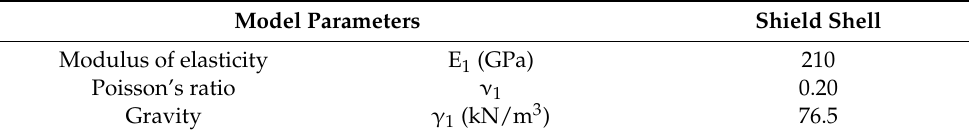
Table 3. Shield machine shell parameters.